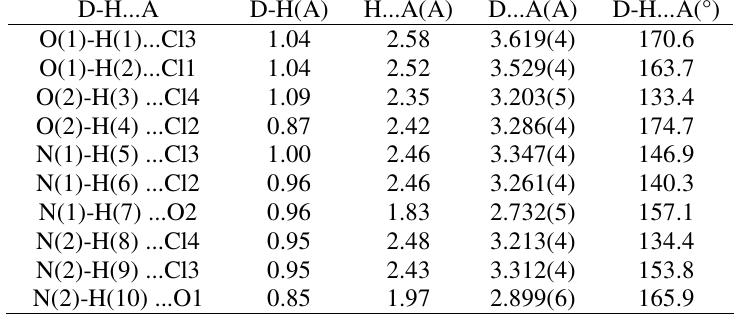
Figure 3. Projection of a layer, viewed down the b direction, in the structure of [2,6-(CH C H NH ] ZnCl .2H O. 6 3 3 2 4 2 Table 4. Hydrogen-bond scheme in [2,6-(CH